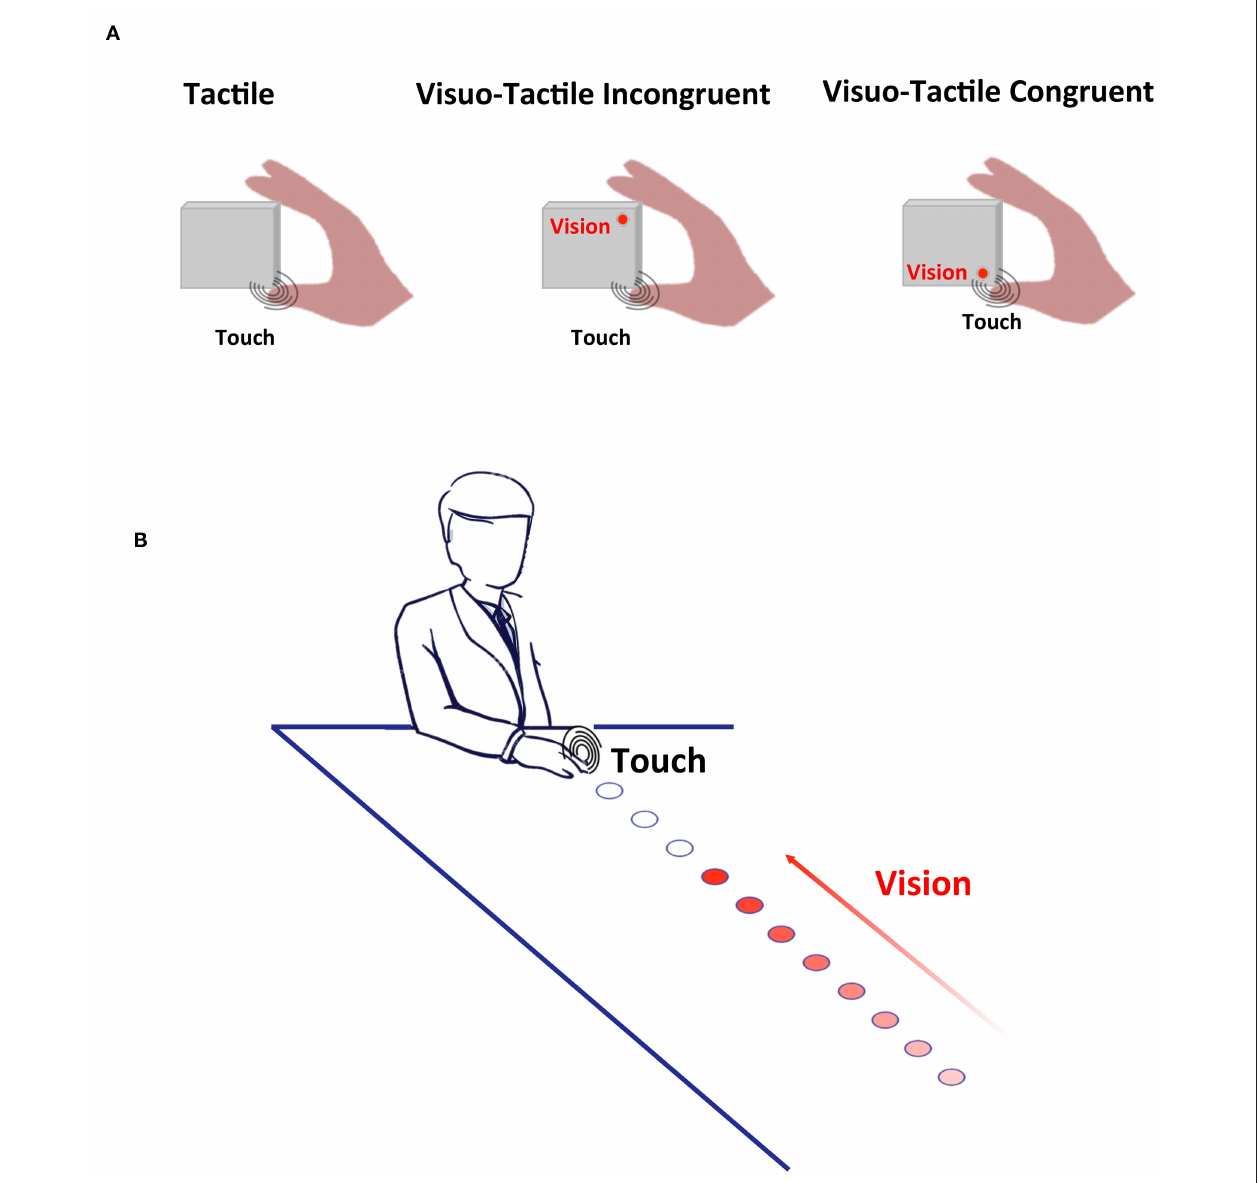
FIGURE 1 | Experimental Methods. (A) Cross-Modal Congruency. Participants responded as fast as possible to touch being applied either to the thumb (depicted) or the index finger. On a fraction of trials, a visual stimulus was also presented, either incongruently with the location of touch (middle panel) or congruently with the location of touch (rightmost panel). (B) Peri-personal Space. On catch trials visual stimuli were presented alone, and on baseline trials, tactile stimuli were presented alone. On the experimental trials (depicted), touch was given when the train of visual stimuli terminated at different distances from the body, and either looming or receding from the participants. In this case looming stimuli is shown, with increasing intensity conveying the direction of movement of the light